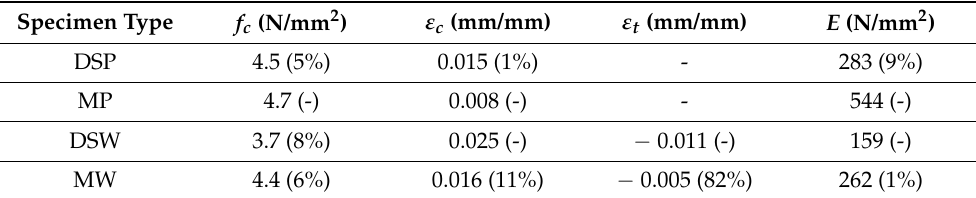
Table 7. Average results from the compression tests conducted on the masonry prisms and on the masonry wallettes (CoV in parentheses).